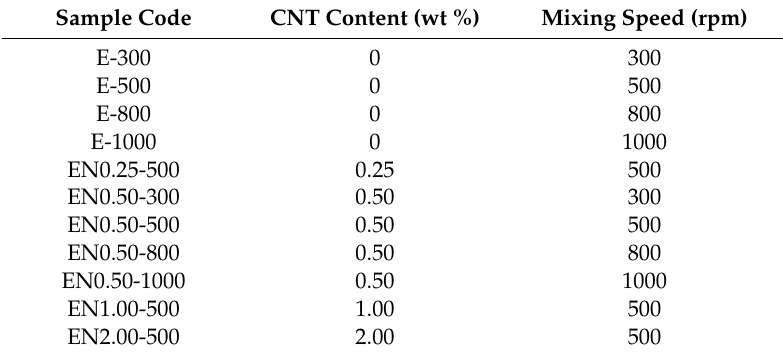
Table 1. Labels of microcapsule batches with di ff erent carbon nanotube (CNT) contents formed at di ff erent mixing